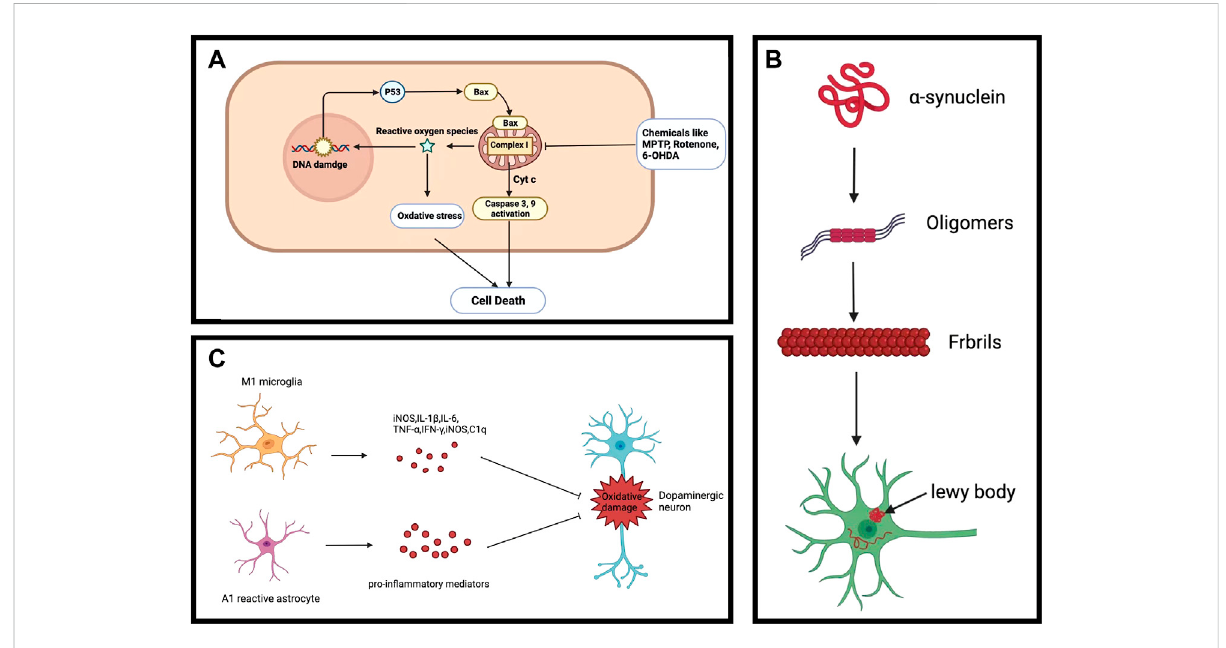
FIGURE 3 Common PD characteristics. (A) Dopaminergic neuronal death. (B) Alpha-synuclein aggregation. (C) Neuroin fl